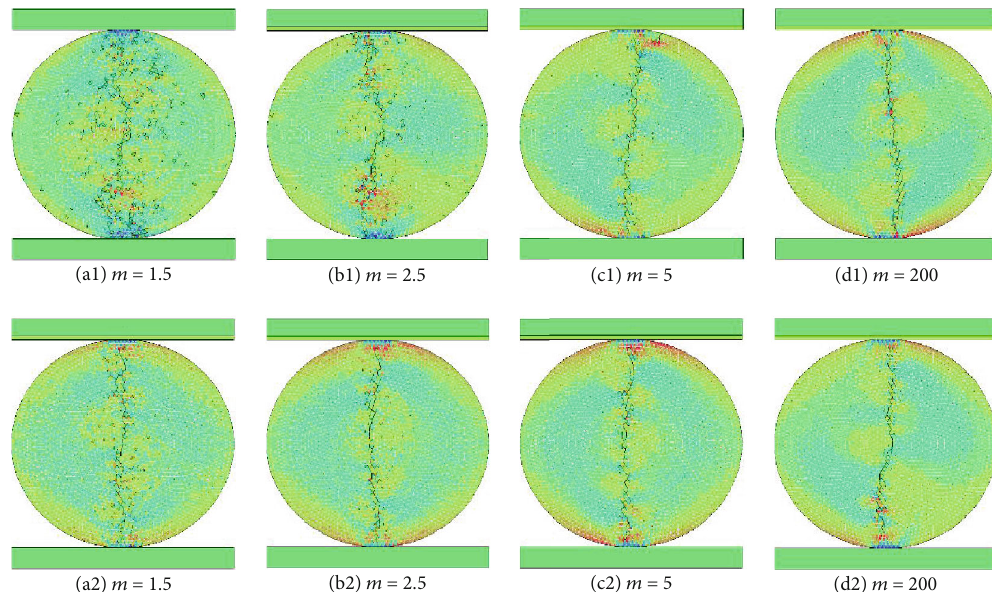
) m = 1 : 5 ; (b ) m = 2 : 5 ; (c ) m = 5 ; (d ) m = 200 1 1 1 1